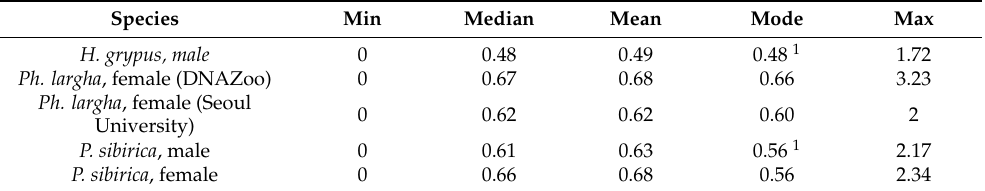
Table 3. Statistical metrics of heterozygosity for analyzed samples of three pinniped species. SNPs are counted in 1 Mbp sliding windows, with a 100 kbp step size, and scaled to SNPs per kbp. Species Min Median Mean Mode Max H. grypus, male